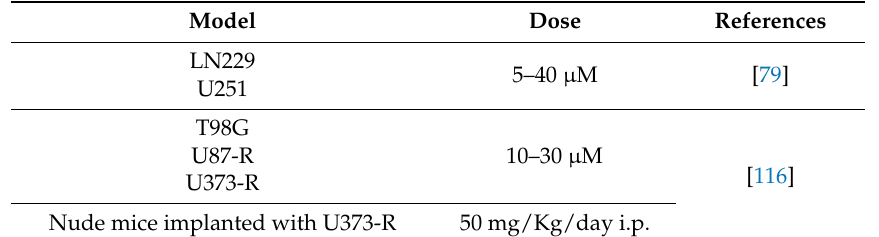
Table 3. Summary of main studies focused on the anti-chemo/radio resistance induced by SFN in GBM.